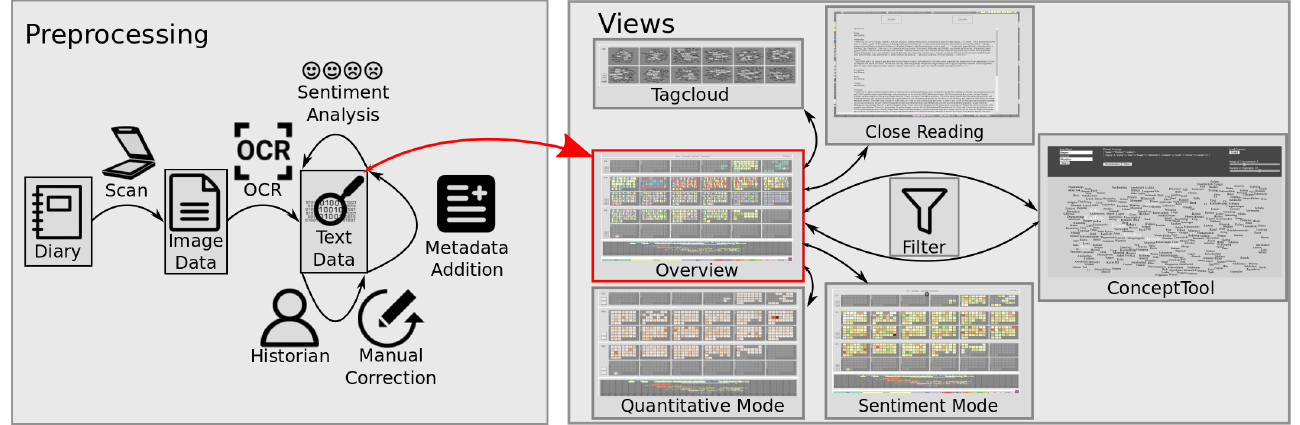
Figure 1. Process illustration for the preprocessing ( left ) and view ( right